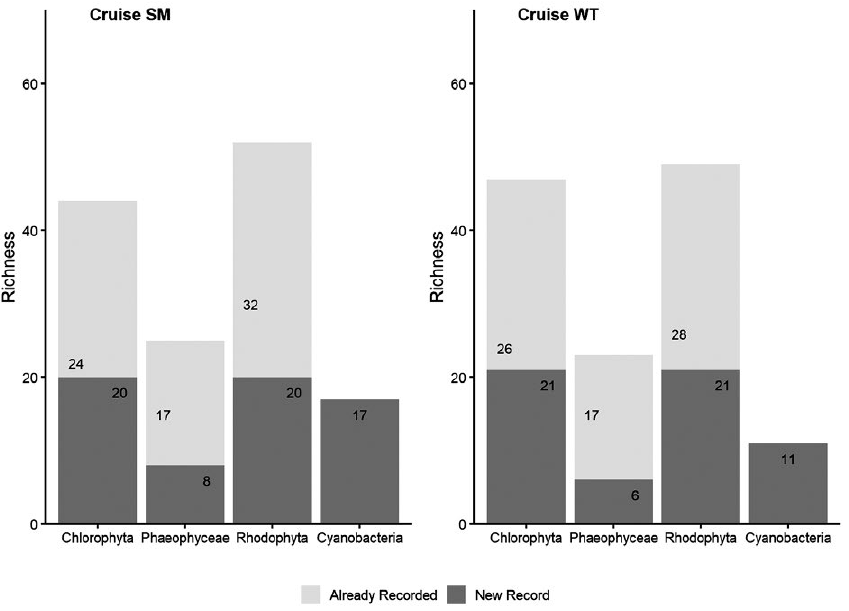
Fig. 5. – Temporal richness distribution of macroalgae groups and cyanobacteria from Trindade Island (southeastern Brazil, southwestern Atlantic), considering taxa already recorded (previous studies) and new records (present study) during summer and winter cruises (SM and WT,